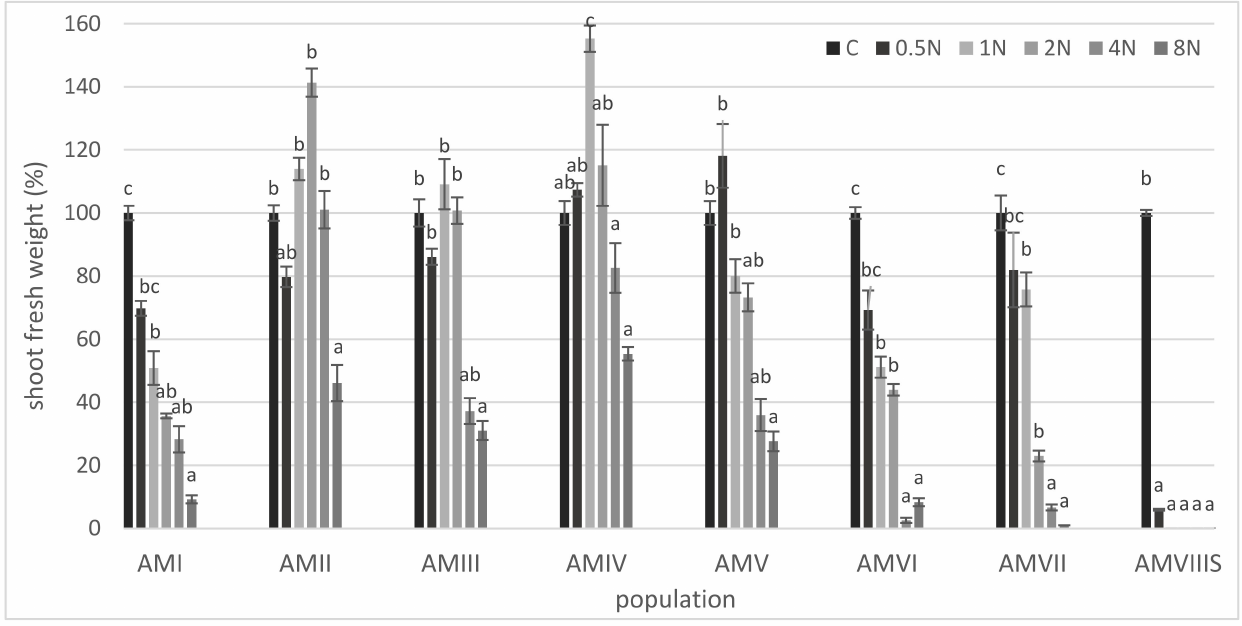
Figure 6. Shoot fresh weight of treated and untreated pinoxaden plants of A. myosuroides , expressed as a percentage of the control. The statistical analysis of the significance of differences was performed using the Tukey test for each population separately. Data are means ± SE, n = 3. Means marked by the same letter do not differ significantly. C: untreated